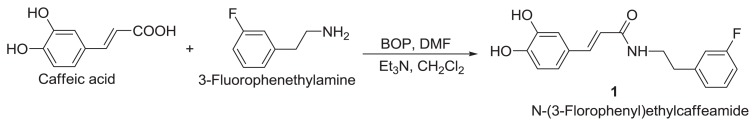
The synthetic procedure and chemical structure of FECA.